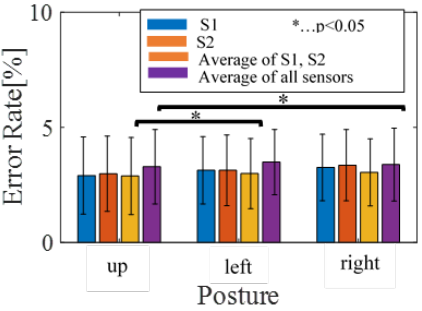
Figure 8. The average of error